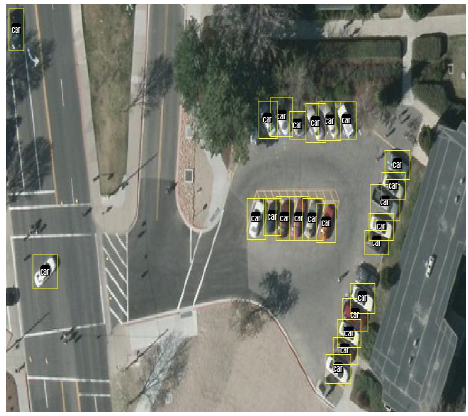
Figure 3: Illustration of the